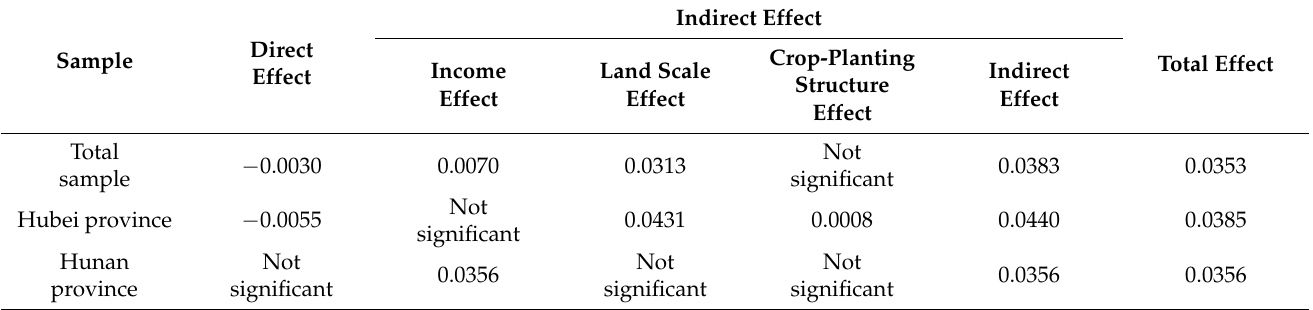
Table 6. Summary of the pollution effect and decomposition conclusions of rural labor